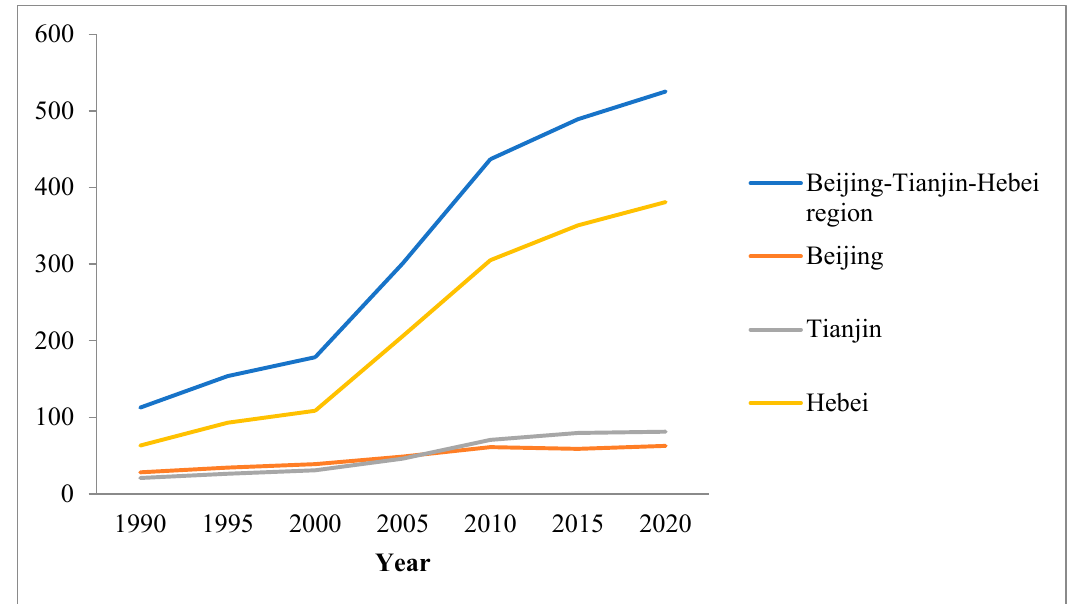
Figure 3. Changing trends of net carbon emissions in the Beijing-Tianjin-Hebei region from 1990–2020 (million tons).